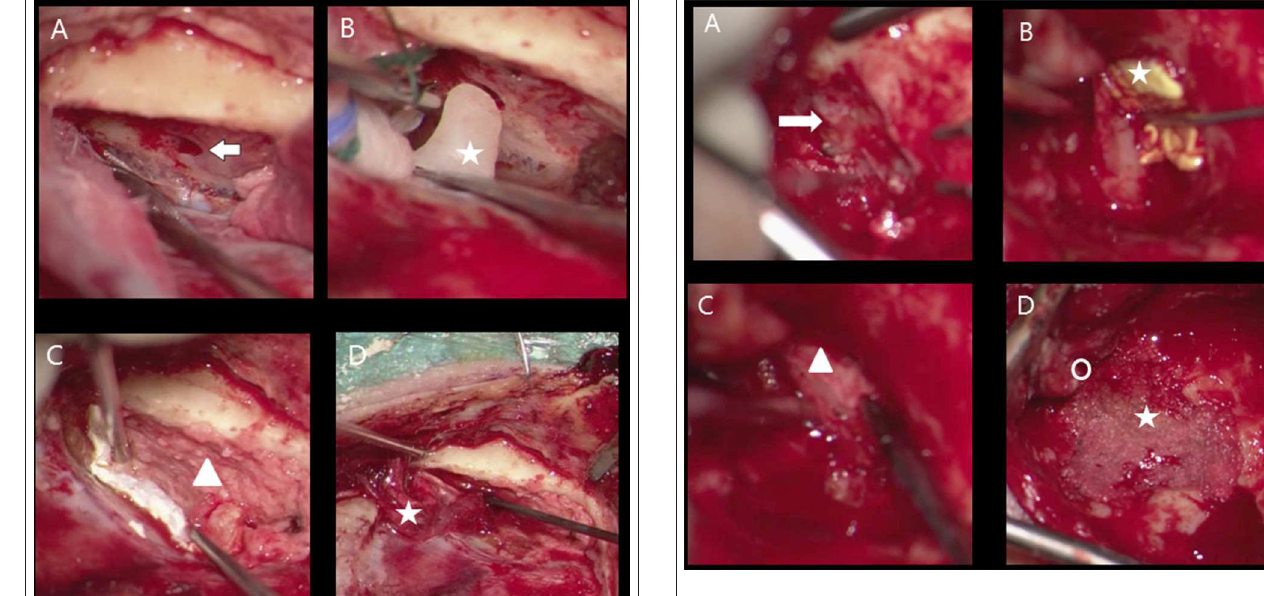
FIGURE 2 | Transmastoid approach meningocoele left ear, obliteration mastoid cavity (A) defect tegmen mastoideum (flash), (B) tachosil coverage dural defect (star), (C) reconstruction bony tegmen defect with bone chip (triangle) and dural defect with tachosil, (D) obliteration cavity with bone dust (star), posterior from new bony ear canal